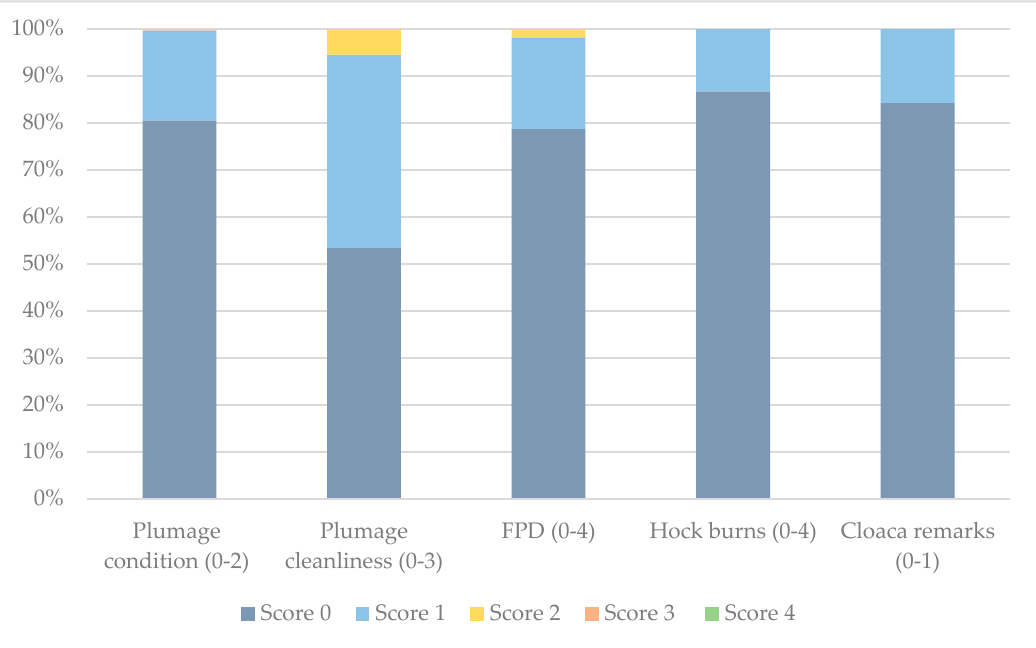
Figure 3. Litter quality assessment scores (Welfare Quality ® ) for Swedish organic broiler farms ( n = 7): number of observations ( n = 35) with score 0–4 at five standardised locations in rearing compartments.